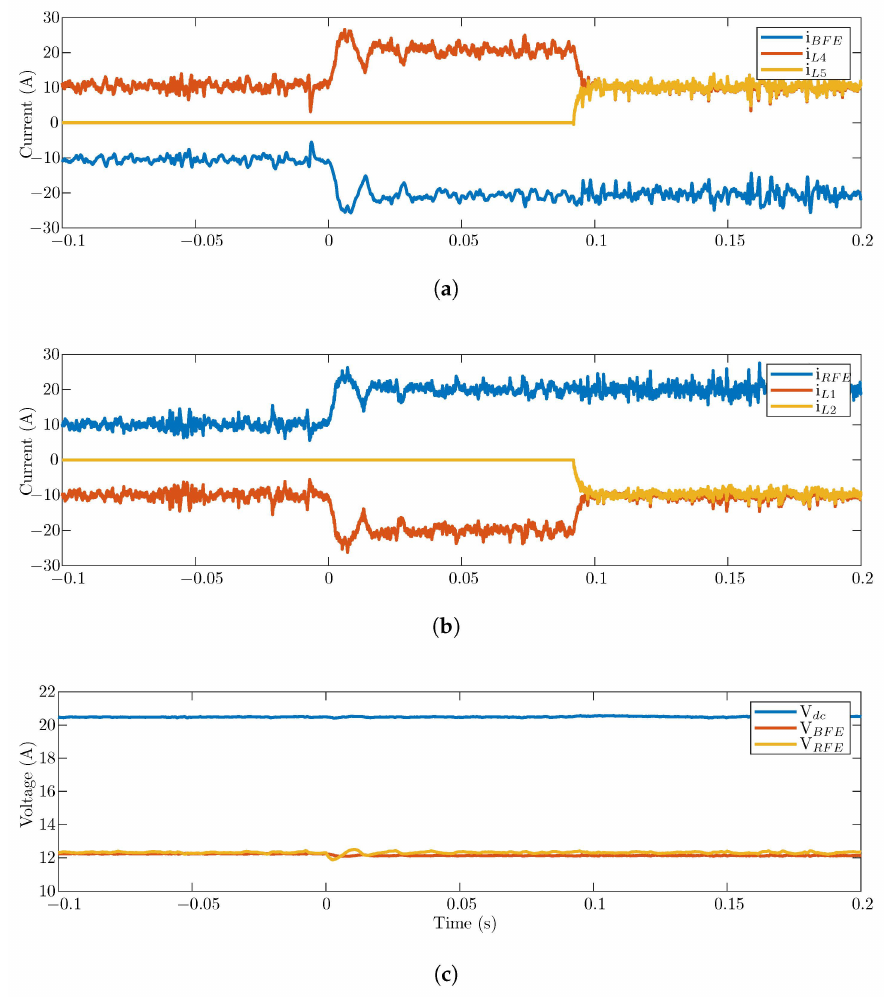
Figure 11. Converter response to a load step from 10 to 20 A. As the controller updates the RMS current value, it turns the second leg on and handles the current sharing, disturbing the terminal voltages. ( a ) BFE currents; ( b ) RFE currents; ( c ) BFE, DC, and RFE